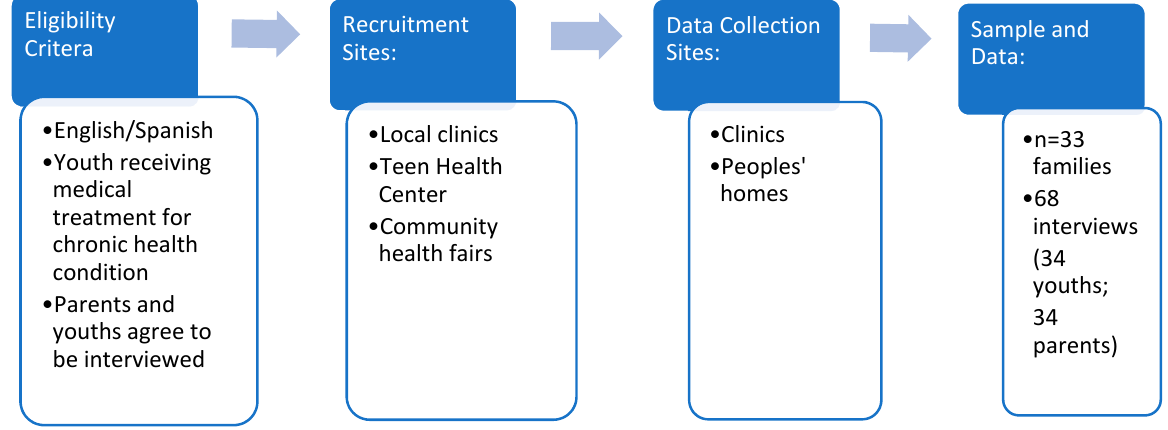
Figure 1. Phase 1 research design and data collection.